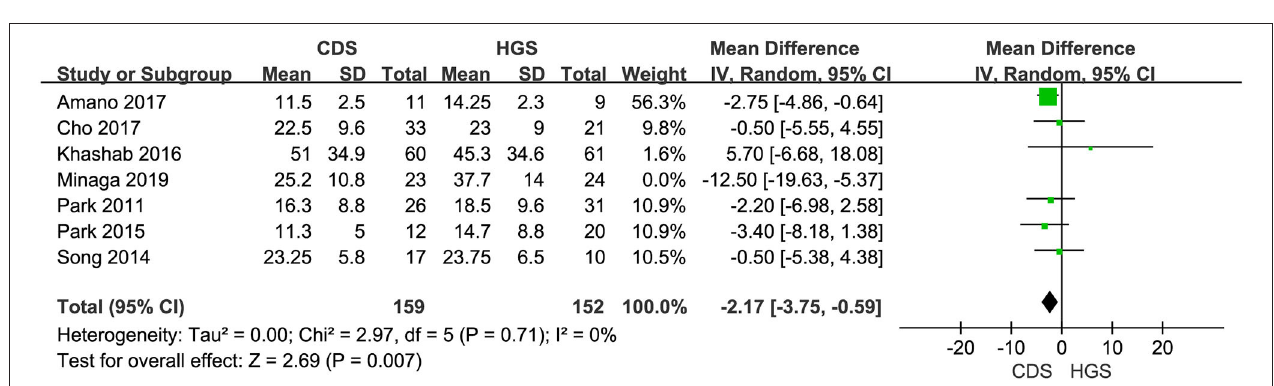
FIGURE 8 | Forest plot of procedure time between EUS-CDS and EUS-HGS (Exclude Minaga’s study).